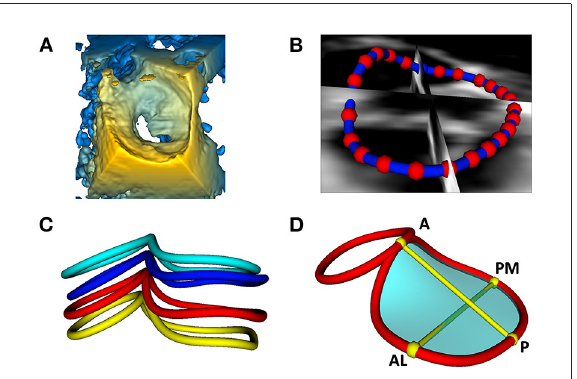
FIGURE3 Visualization and modeling of mitral valve annuli. (A) Volume rendering of a 3DE of a mitral valve using the echo volume render module in SlicerHeart. (B) Curve creation of annular model of a mitral valve visualized through 2D slice intersections using valve annulus analysis module in SlicerHeart. (C) Visualization of mitral and aortic annular curves in all four phases of the cardiac cycle (top to bottom: End Diastole, Mid Diastole, Mid Systole, End Systole). (D) Quantification of mitral and aortic annuli using valve quantification module in SlicerHeart. 3DE, 3D echocardiogram; A, Anterior; P, Posterior; AL, Anterolateral; PM, posterior